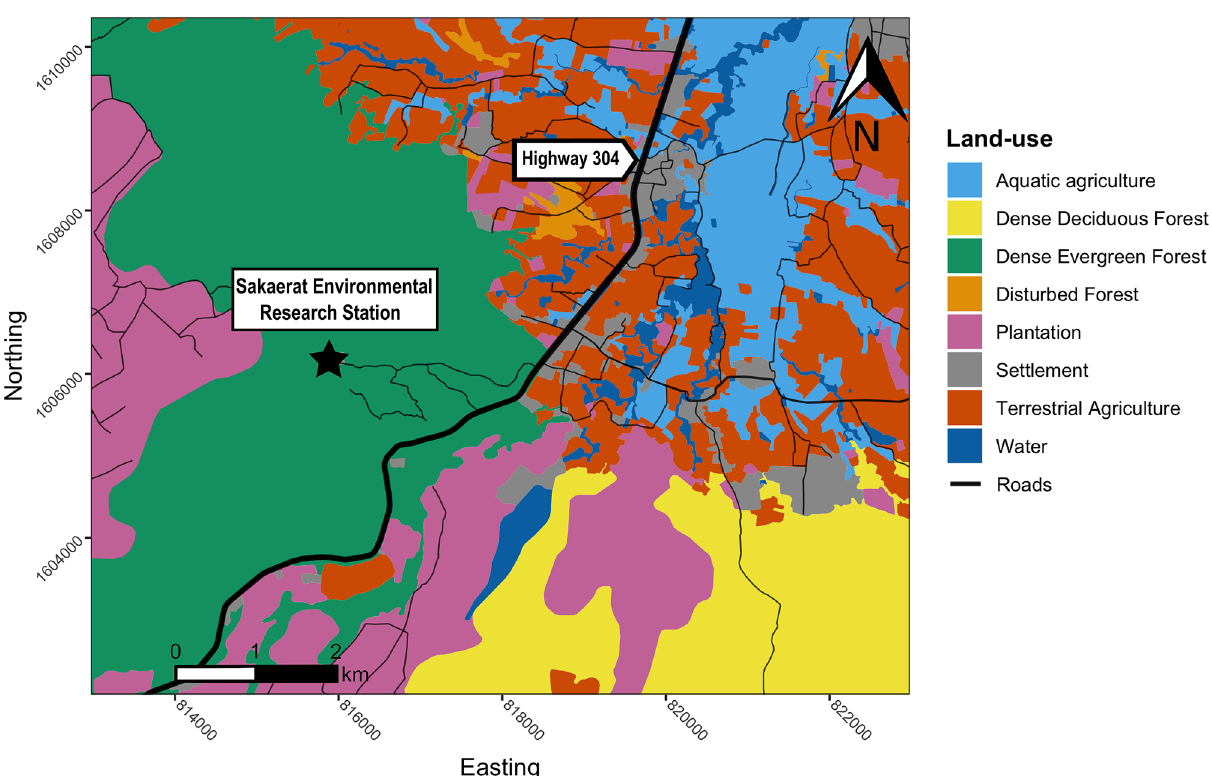
Figure 1. A map illustrating the land-use types spanning the area of which Burmese pythons ( Python bivittatus ) were tracked within the Sakaerat Biosphere Reserve, Nakhon Ratchasima, Thailand. Map created using R v.3.6.3 (https:// www.r- proje ct. org/) in RStudio v.1.2.1335 (https:// rstud io. com/) in combination with Inkscape v.1.0.2 (https:// inksc ape.